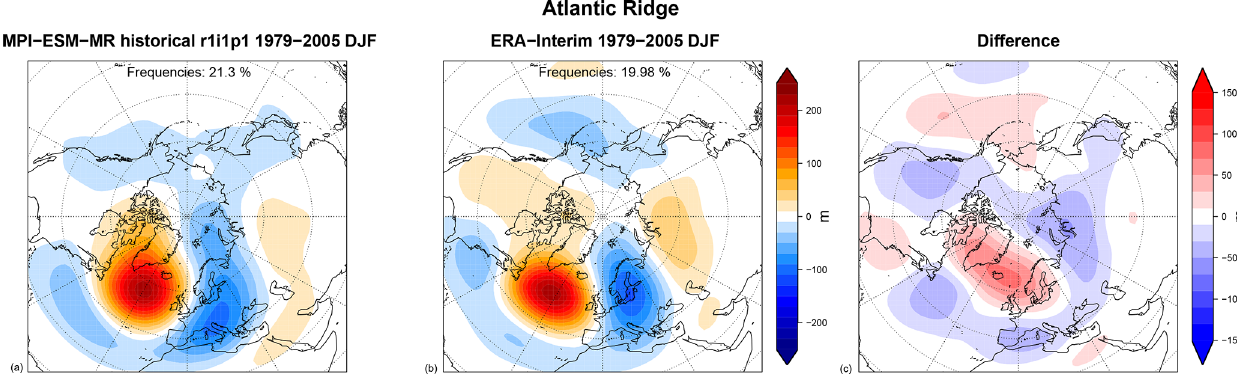
Figure 18. 500hPa geopotential height anomalies (m) associated with the Atlantic Ridge weather regime over the 1979–2005 DJF period for (a) the CMIP5 MPI-ESM-MR historical r1i1p1 run, (b) the ERA-Interim reanalysis, and (c) their differences. The frequency of occupancy of each regime is reported at the top of each panel. Produced with recipe_miles_regimes.yml ; see details in Sect. 3.2.5.